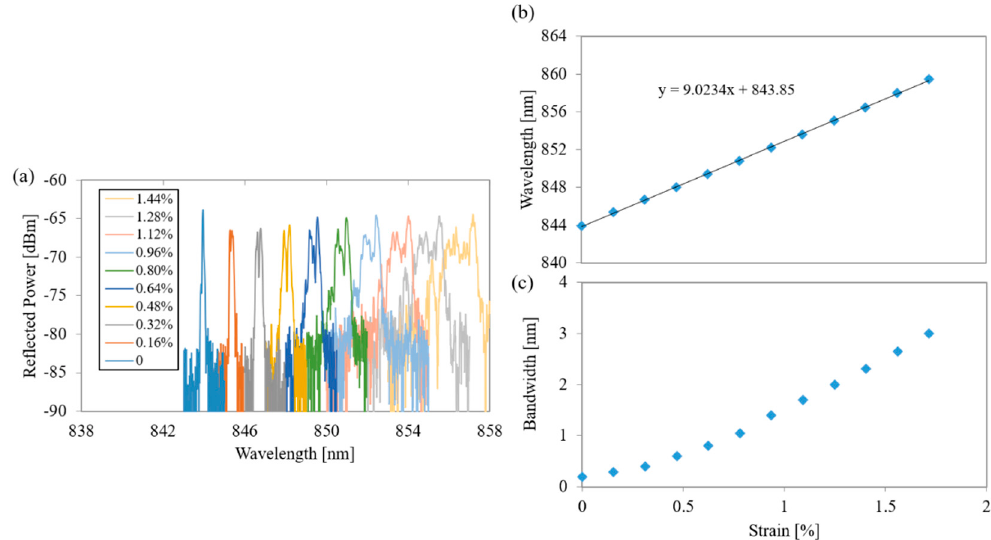
Figure 11. ( a ) Reflected spectral power vs strain, ( b ) wavelength shift vs strain, and ( c ) bandwidth vs strain; image adapted from [116].